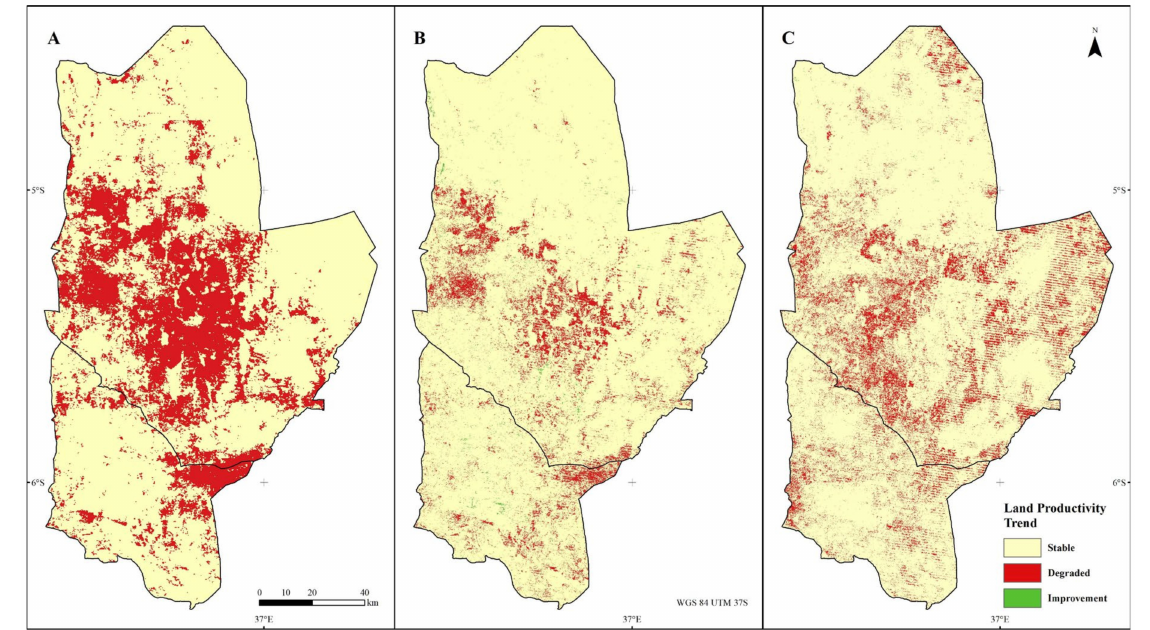
Figure A1. The land productivity component trend generated using ( A ) the default approach with MODIS imagery, ( B ) the adapted approach with Landsat imagery for the baseline period, and ( C ) the adopted approach with Landsat imagery for the monitoring period 2015–2019.